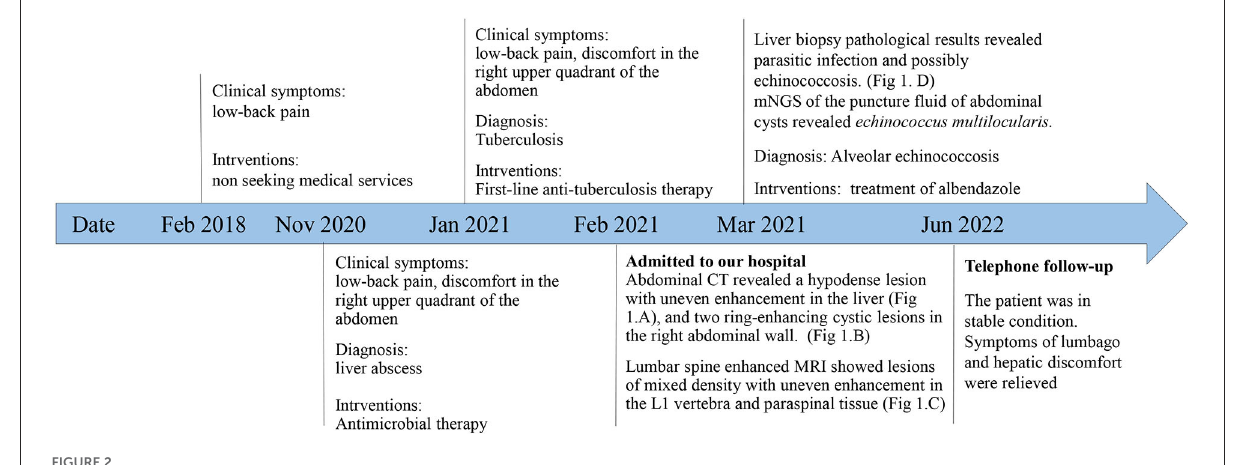
FIGURE2 Timeline of the patient with relevant data of the past episodes and